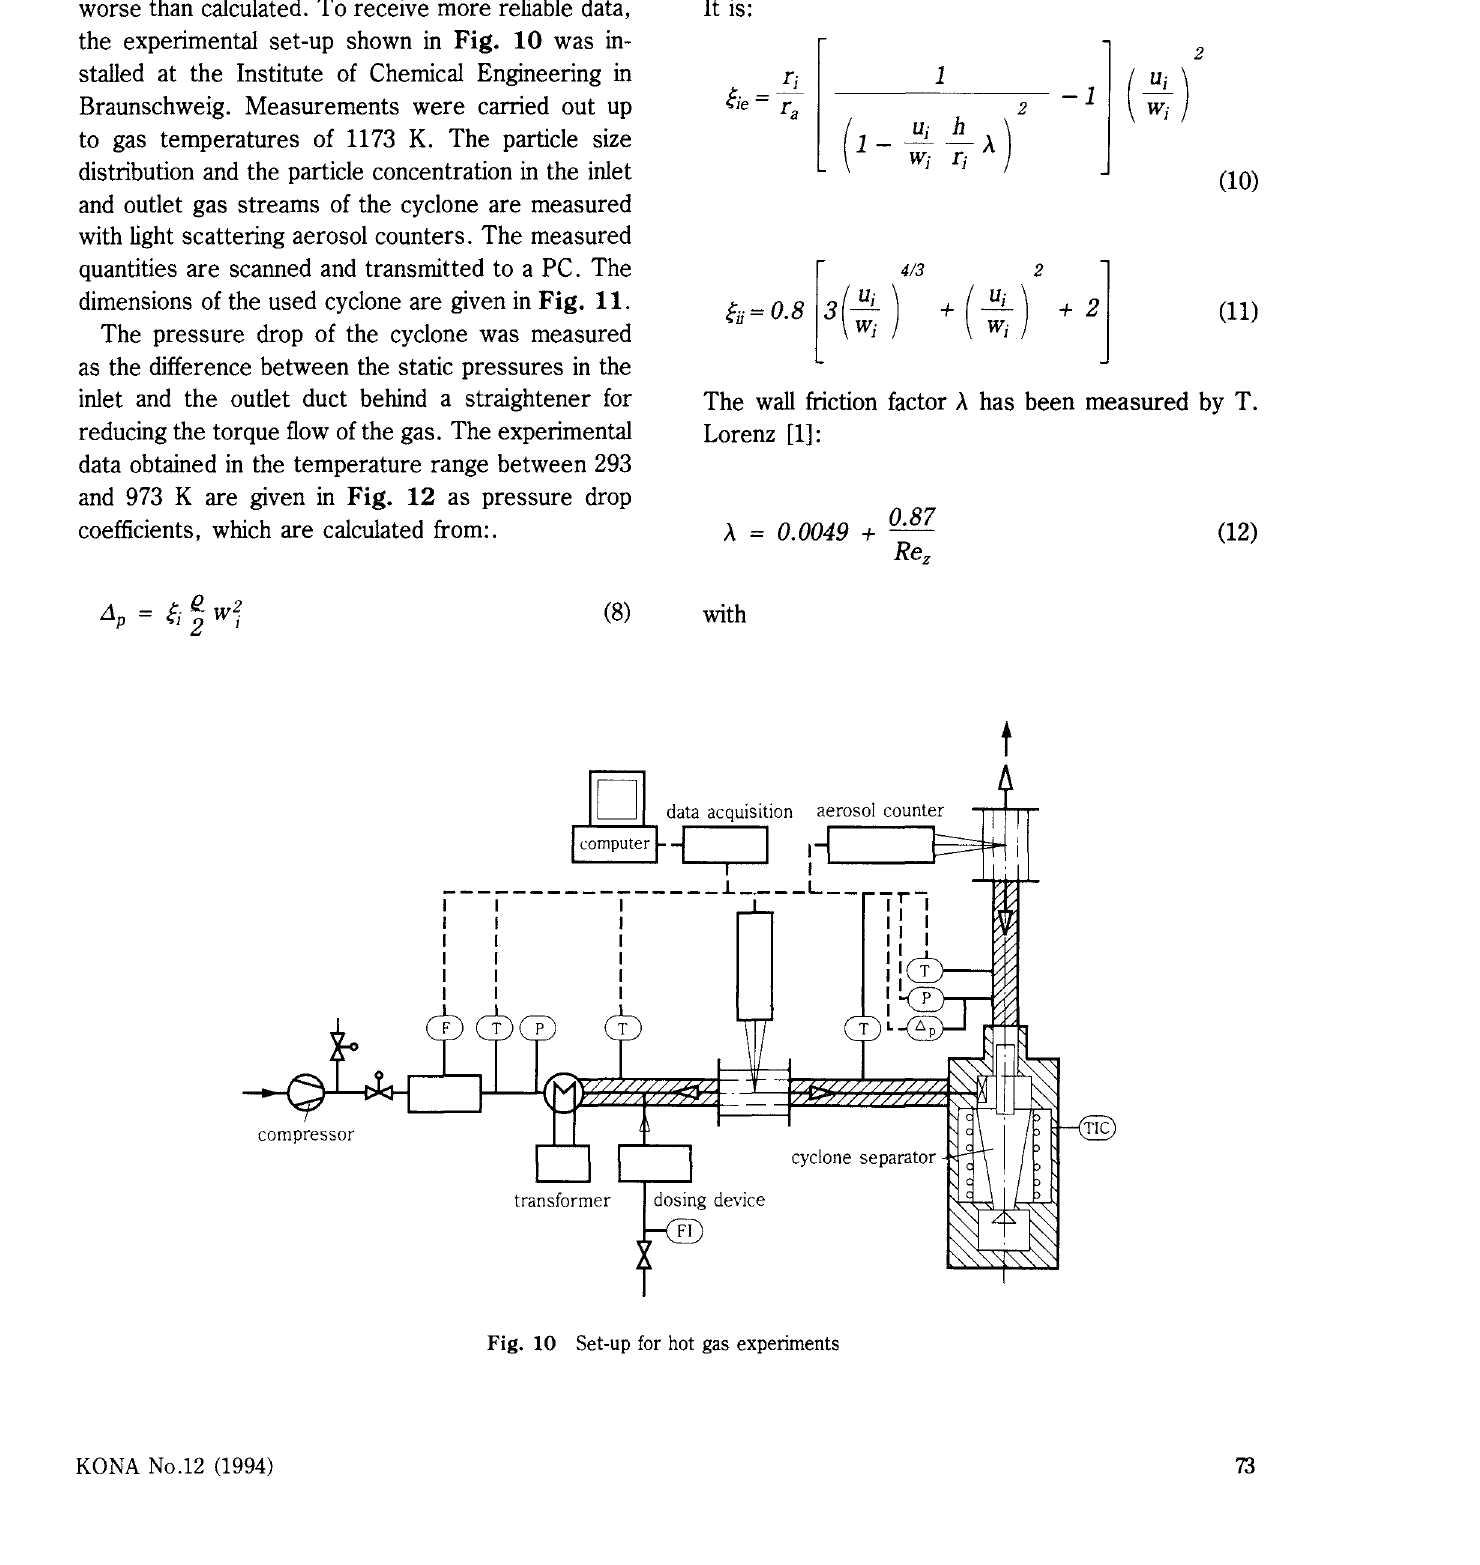
Fig. 10 Set-up for hot gas